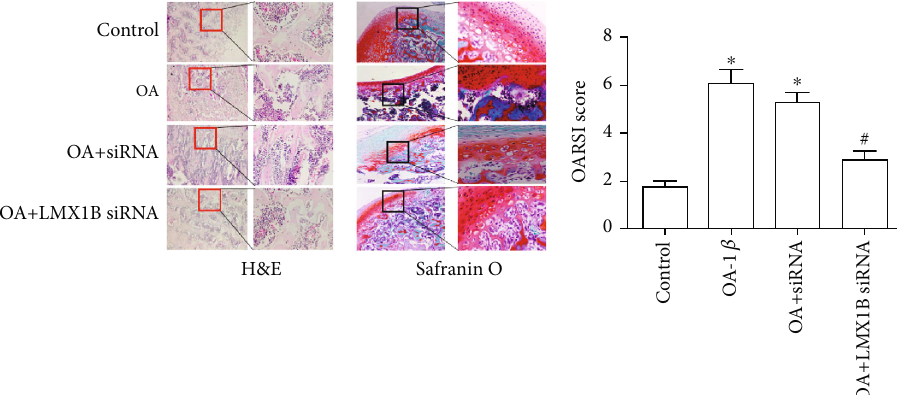
Figure 9: LMX1B depletion suppressed pathogenesis of osteoarthritis in Sprague-Dawley rats. Representative images of HE and Safranin O staining, OARSI grade in control, OA, control siRNA, and LMX1B siRNA group. ∗ P < 0 : 05 , compared with the control group; # P < 0 : 05 , compared with the OA group. In the study, 7 rats were used in each